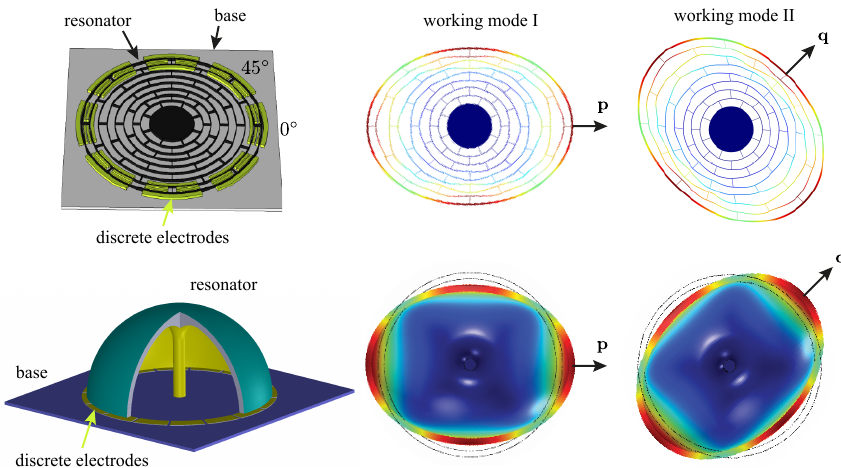
Figure 1. Mode shape with the wavelength of n = 2 in a micro multi-ring resonator and a micro hemispherical resonator.